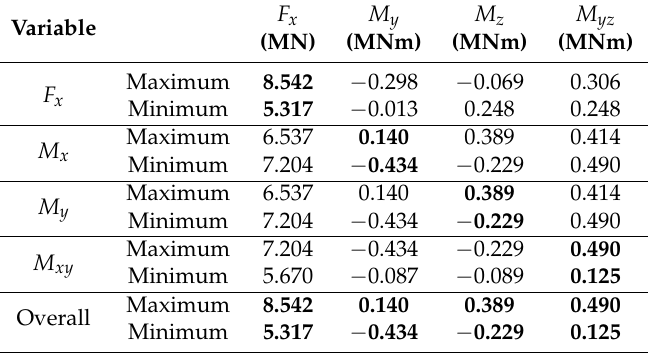
Table 1. Example ultimate loads table. This shows typical results from a structural response analysis for a brace member at the bottom of the Offshore Code Comparison Collaboration Continuation (OC4) jacket support structure. Both contemporaneous loads (for each variable) and the standard approach using univariate maxima/minima are shown, the latter in the two bottom rows. These numbers correspond with the time series shown in Figure 1. F, force; M, moment. F x M y M z M Variable